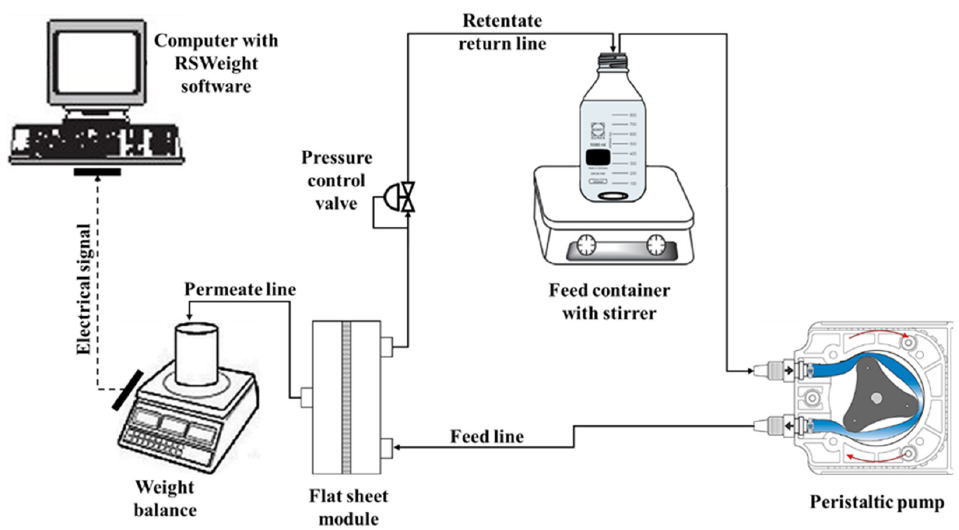
Figure 1. Experimental setup for membrane permeation using the crossflow filtration configura- tion.